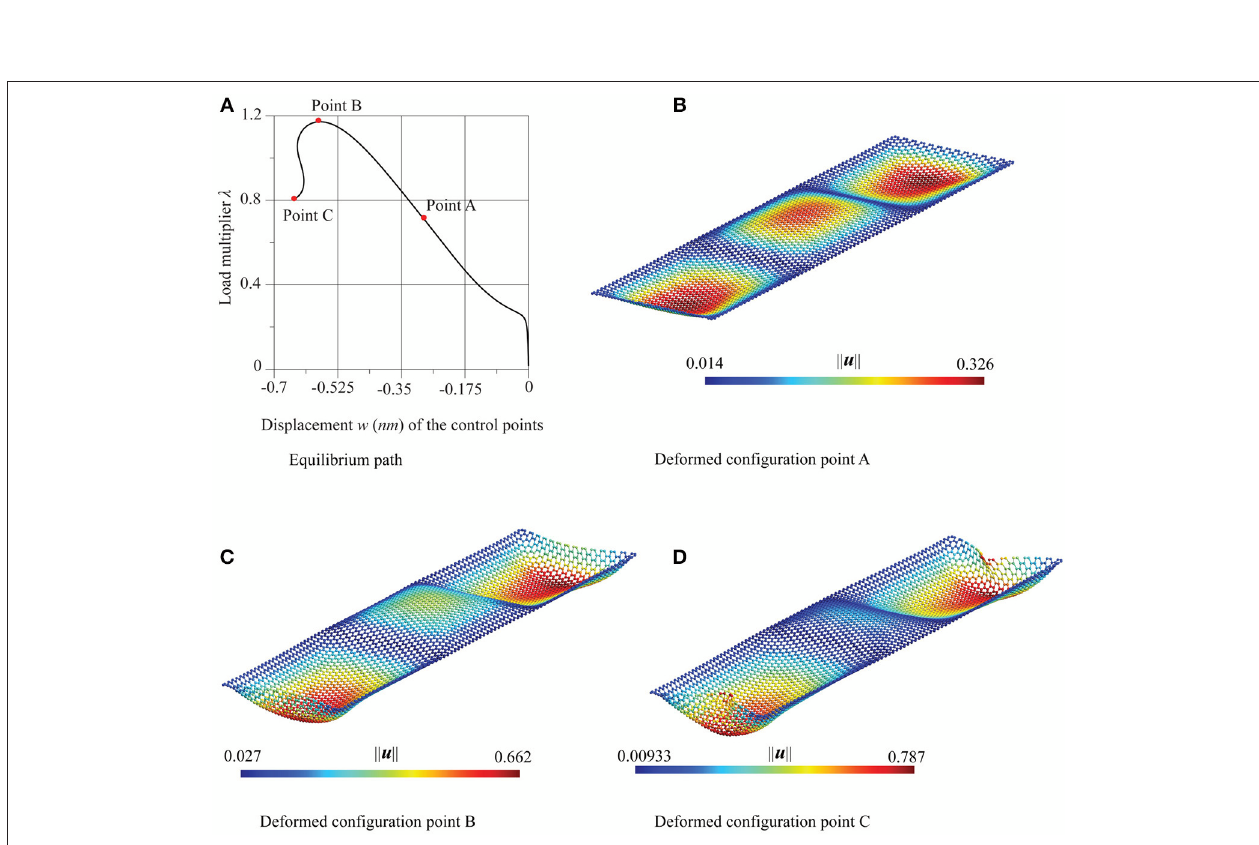
FIGURE 12 | Supported graphene strips under compression in the armchair direction: (A) equilibrium path and (B–D) deformed configurations at the points A , B , and C .